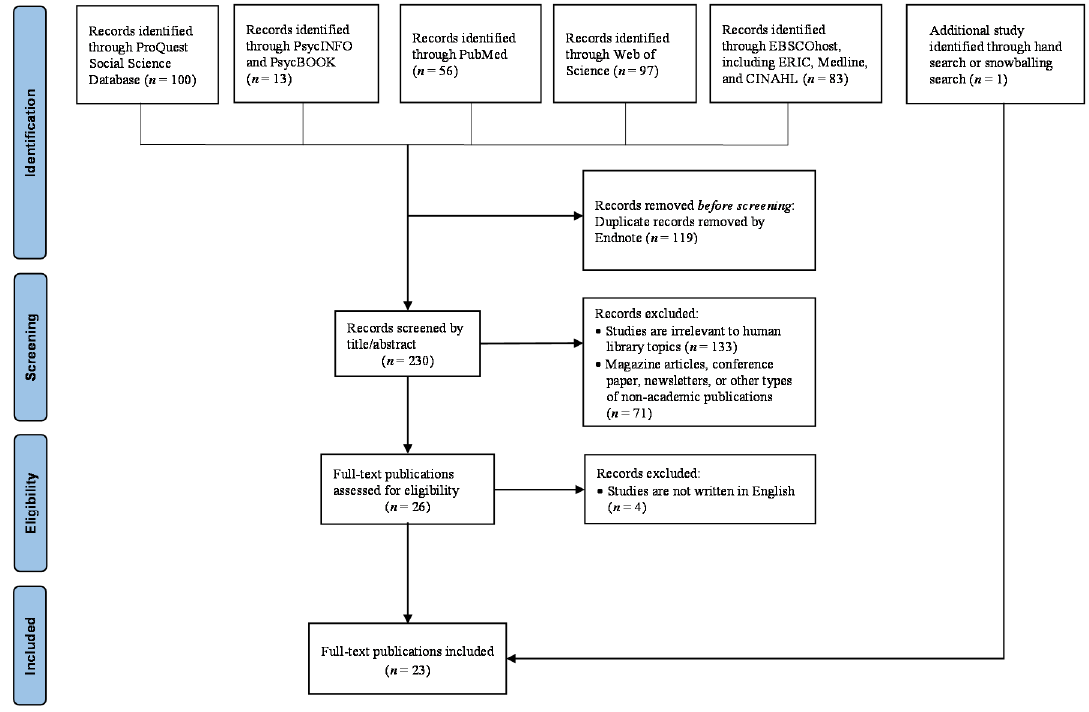
Figure 1. PRISMA diagram of search process and results.